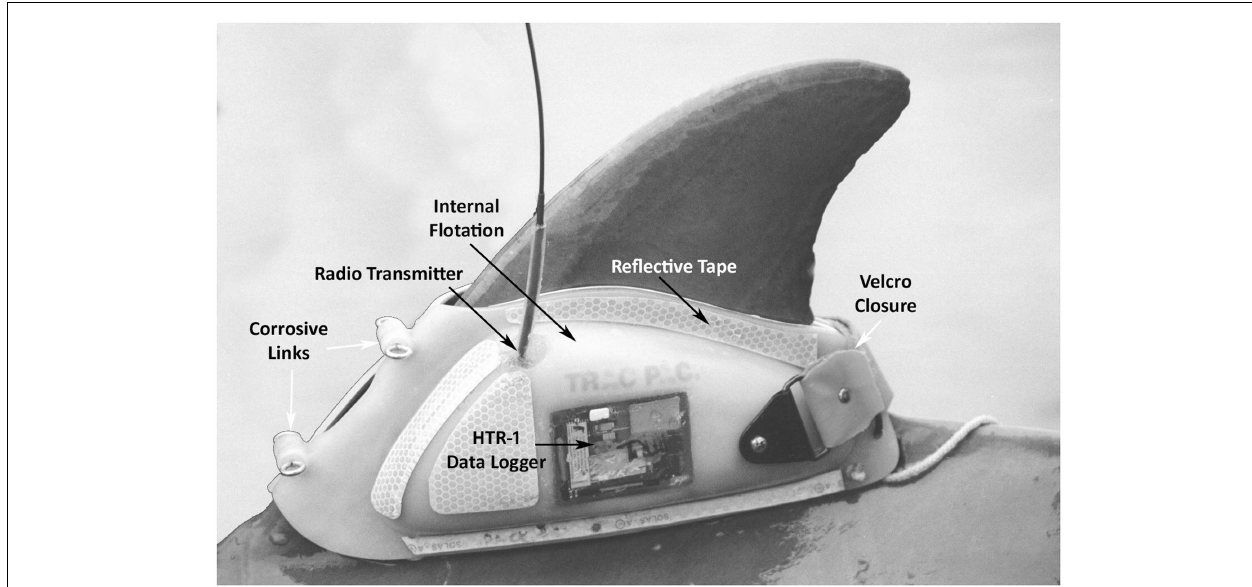
the antenna oriented above water; Corrosive Links composed of zinc barrel and steel eyebolts were size-selected to dissolve between 8 and 24h; ReflectiveTape allowed observers to detect the animal at night using a spot light;Velcro Closure used to compress trailing edge of pack on the fin keeping suction cup liner firmly in place until pack separated at